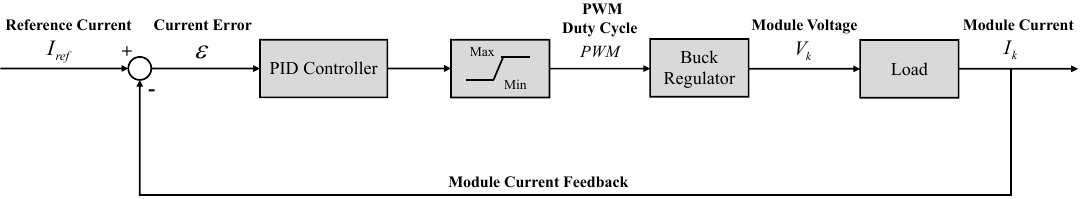
Figure 5. PID current loop control in buck regulated PWM